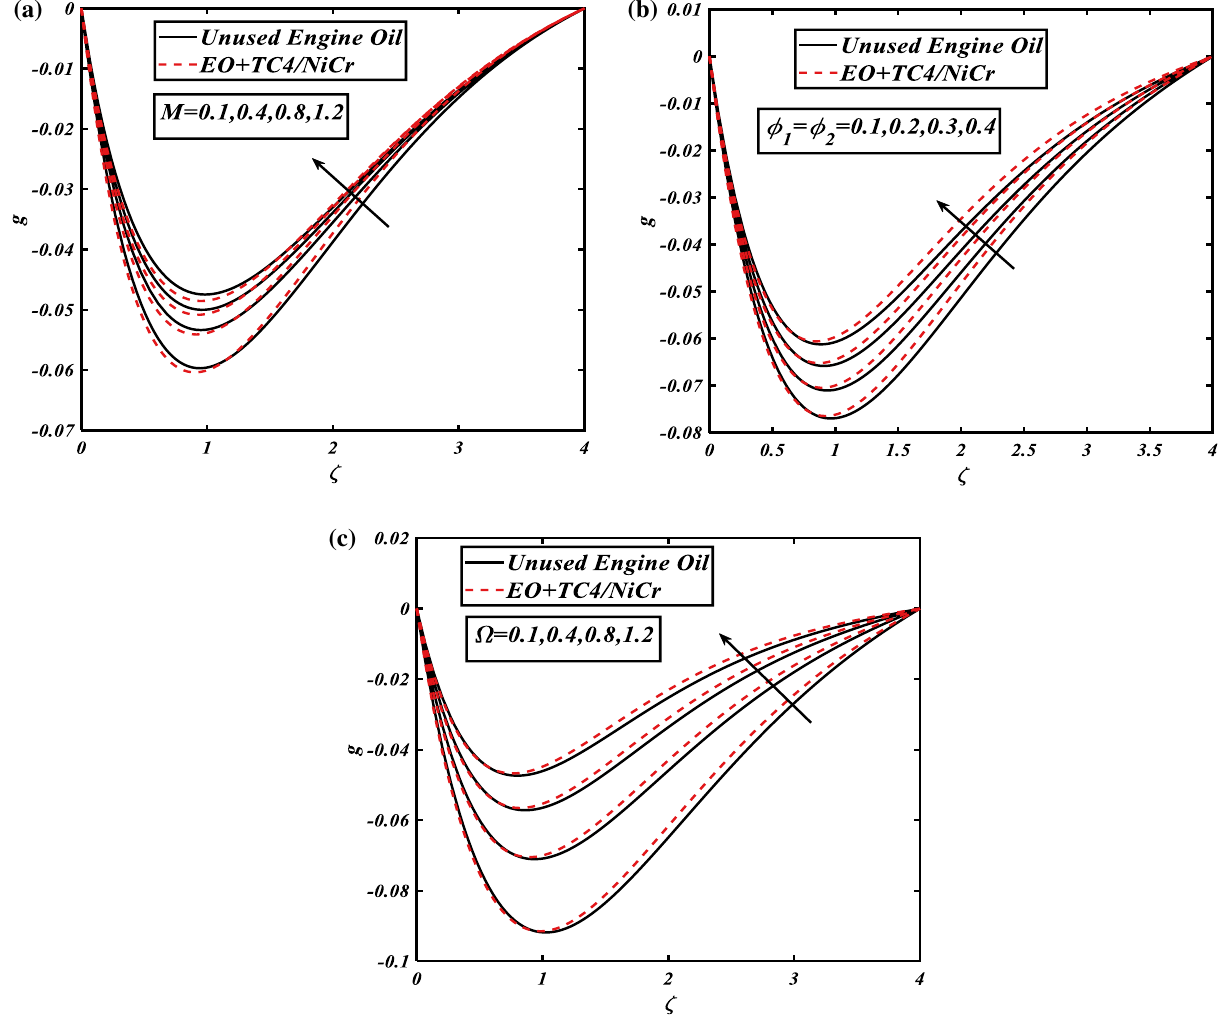
Figure 3. ( a ) Graphical illustration of velocity g against M . ( b ) Graphical illustration of velocity g against φ 1 = φ 2 . ( c ) Graphical illustration of velocity g against (cid:31)